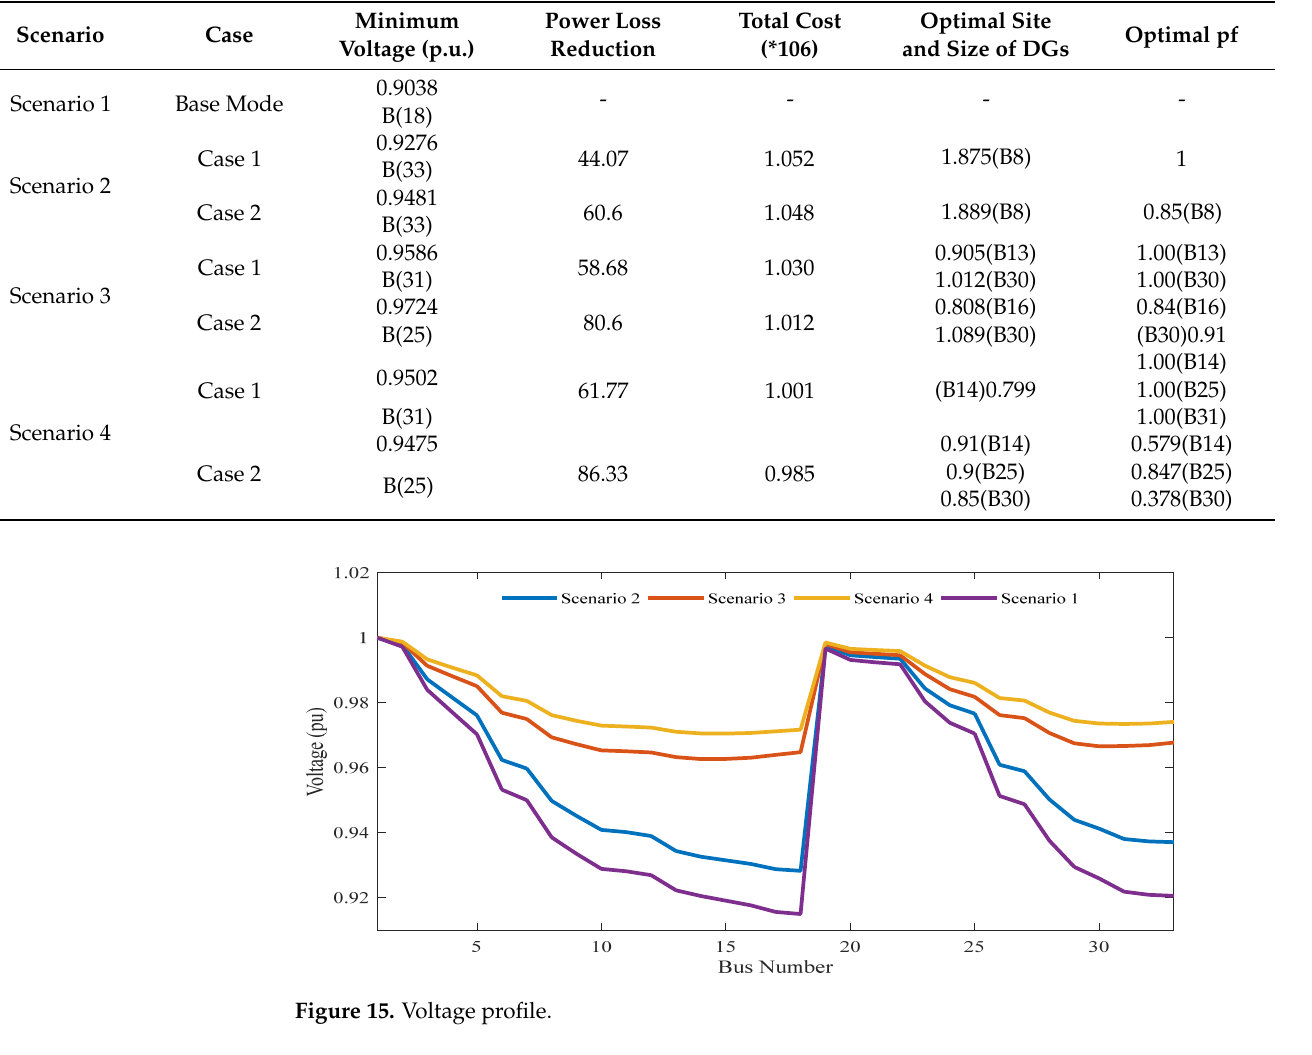
Figure 15. Voltage profile.